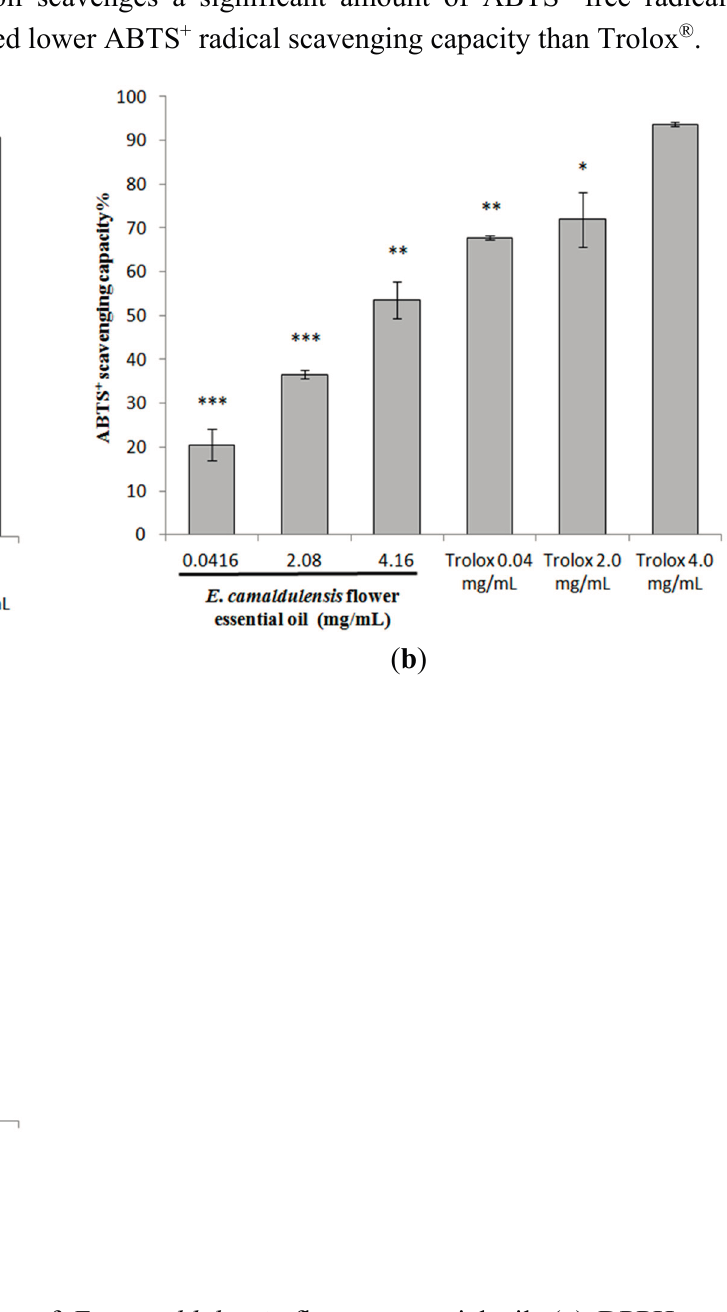
Figure 5. The antioxidant activities of E. camaldulensis flower essential oil. ( a ) DPPH scavenging activity assay; ( b ) ABTS + radical scavenging capacity assay; and ( c ) determination of cellular ROS content. The results are expressed as percentages of the control. The data are presented as the mean ± S.D. * p < 0.05; ** p < 0.01; *** p <